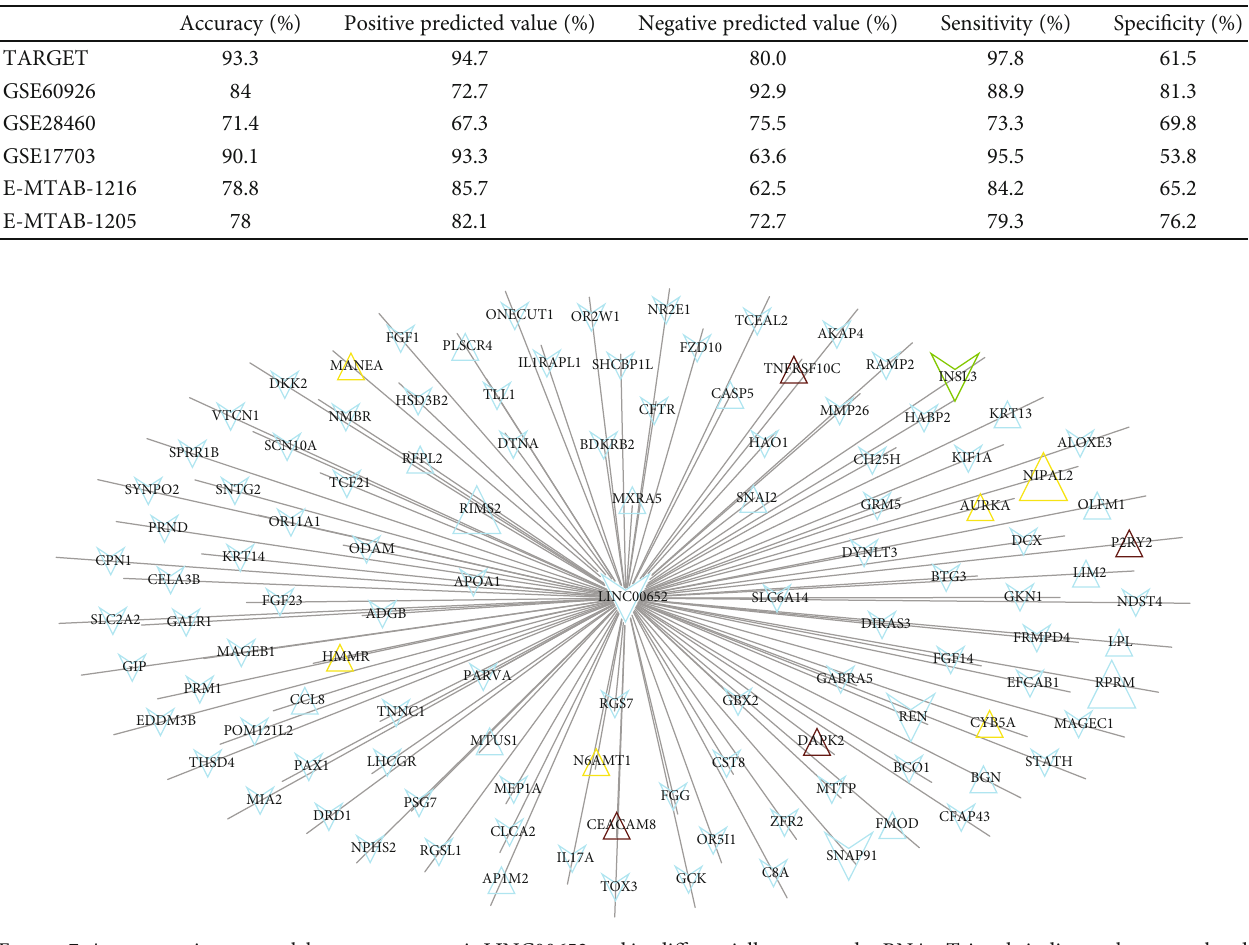
Figure 7: A coexpression network between prognostic LINC00652 and its di ff erentially expressed mRNAs. Triangle indicates the upregulated RNAs; inverted triangle indicates the downregulated RNAs; the color of nodes is corresponding to the module color (turquoise, green, yellow, and brown); the nodes with larger font are prognostic signature